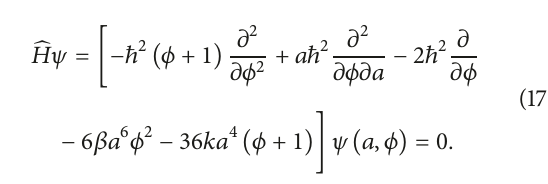
We chose the Weyl ordering for the ambiguous operator products. Thus, we get the nonlinear